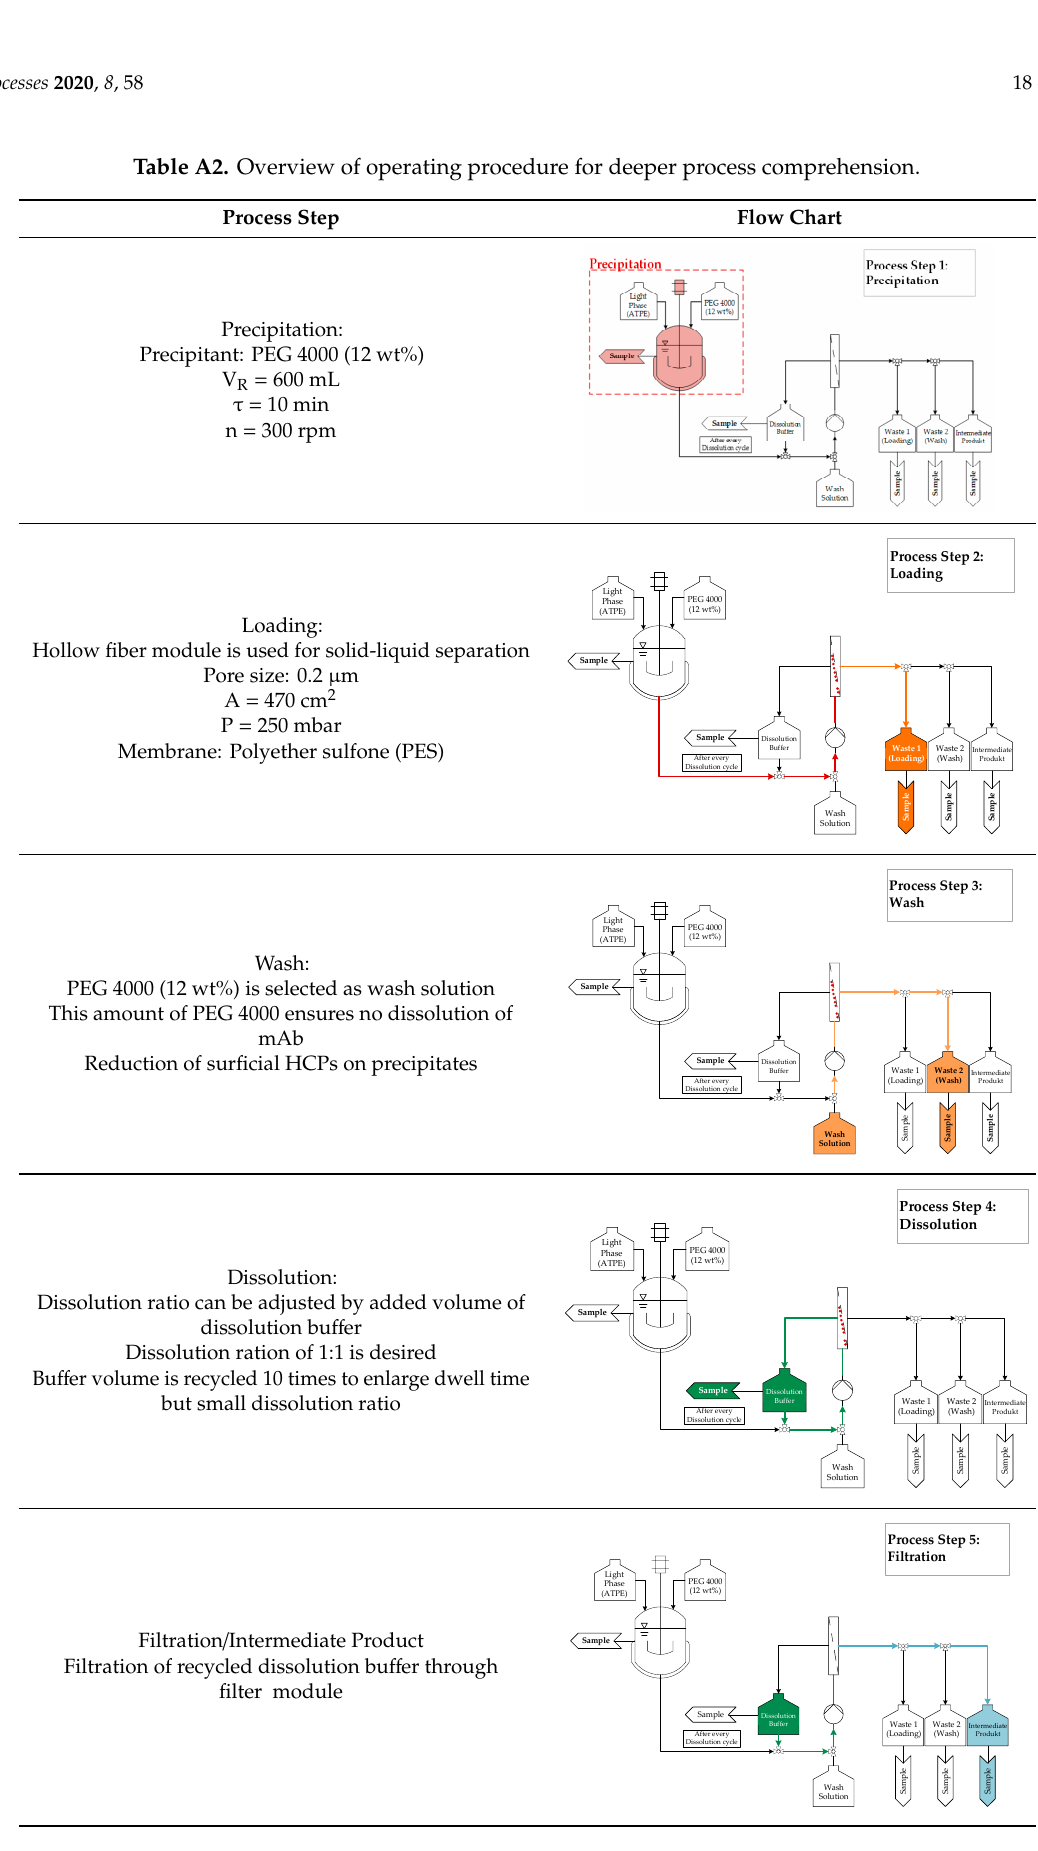
Table A3. Results of the conducted DoE and evaluation of effects on product yield and purity. Process Process Parameter Parameters Range